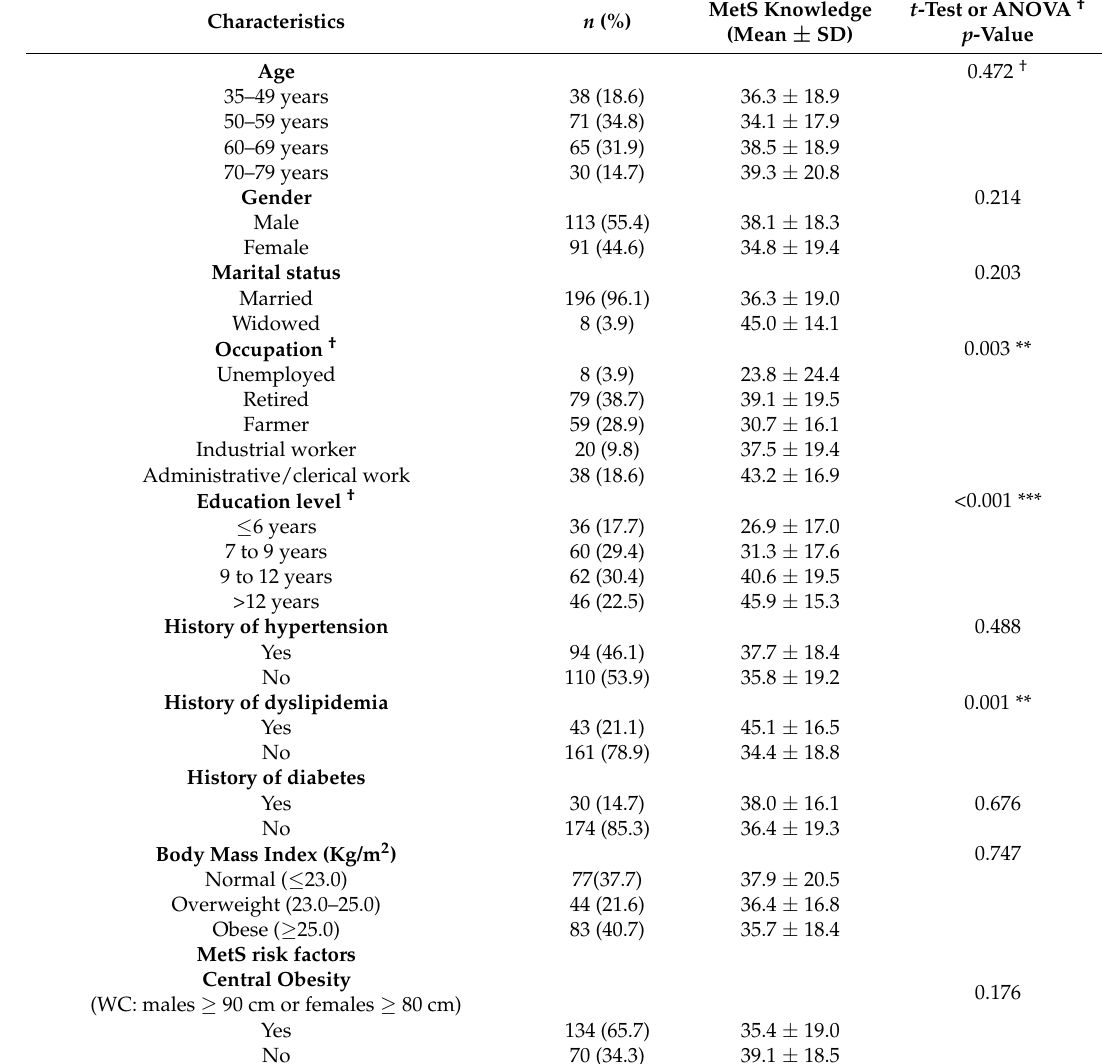
Table 1. Participants’ Characteristics and Knowledge of Metabolic Syndrome (n =